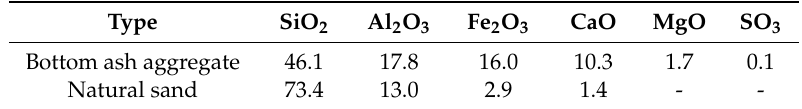
Table 1. Chemical composition of aggregates used.